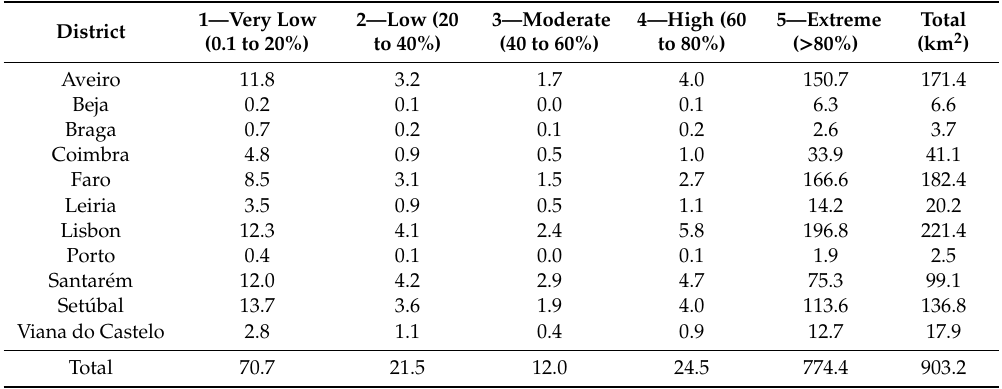
Table 6. Flooding areas (in km 2 ) for each EFHI class interval and respective probability, for the 2050 SLR scenario in each coastal district.